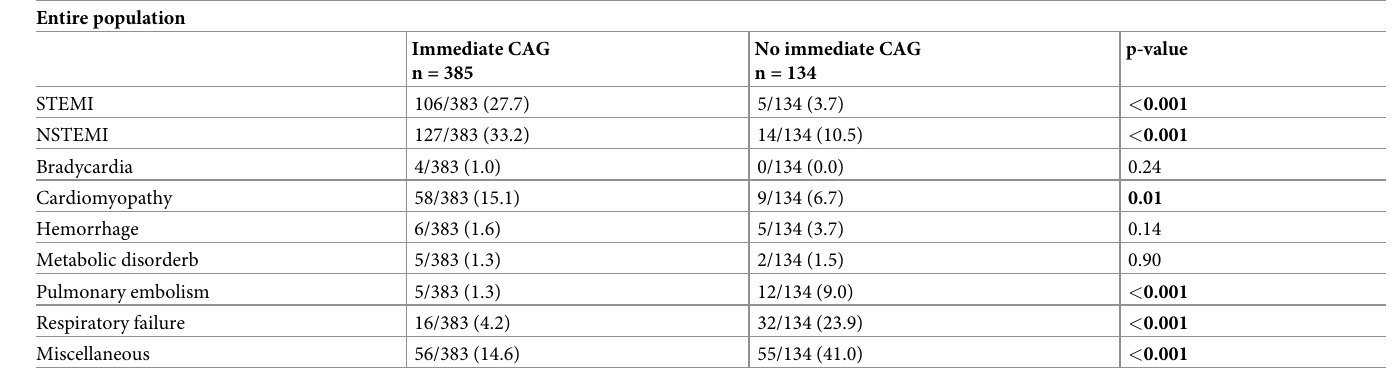
Table 3. Cause of cardiac arrest in patients with and without immediate CAG.